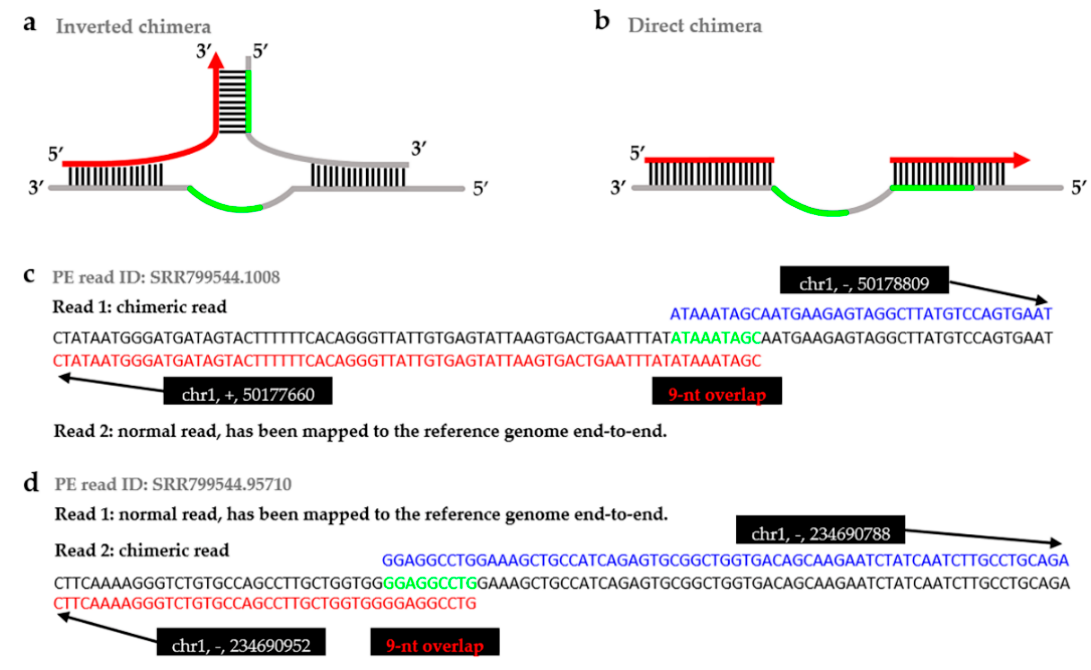
Figure 1. The mechanism of chimera formation and the example visualization of the single-end chimeras. There was branch migration reaction during the MDA processing, because of there exists same sequence (green line in a , b ) on adjacent templates (grey line in a , b ). ( a ) The displaced 3'-end annealed to other template where the sequence on the 3 ′ -end (red arrow in a ) had annealed to the sequence on the 5 ′ -strand (green line in a ), then continued elongation and formed inverted chimera; ( b ) The displaced 3 ′ -end annealed to other template where the sequence on the 3 ′ -end (red line in b ) had annealed to the sequence on the 3 ′ -strand (green line in b ), then continued elongation and formed direct chimera. In ( a , b ), grey lines are DNA templates, black lines represent base pairing, arrows show the direction of elongation, and red lines represent chimeras; ( c ) The chimeric read parts mapped to the reverse strands (+/ − ), defined as inverted chimera; ( d ) The chimera’s parts mapped to the same strands ( − / − ), defined as direct chimeras. The green sequences in ( c , d ) are the overlaps of the chimeras, between the parts of a chimera. The red sequences are part 1 of a chimera, and the blue sequences are part 2 of a chimera.